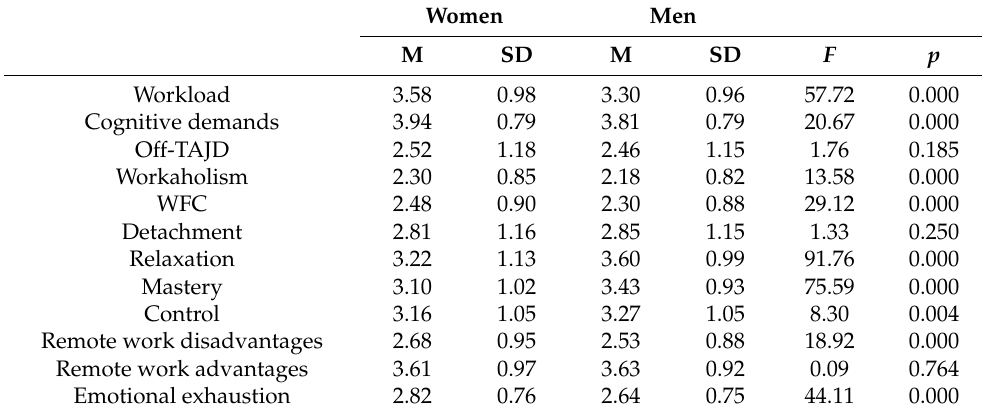
Table 1. Means, standard deviations, and ANOVA for the TAS sample by